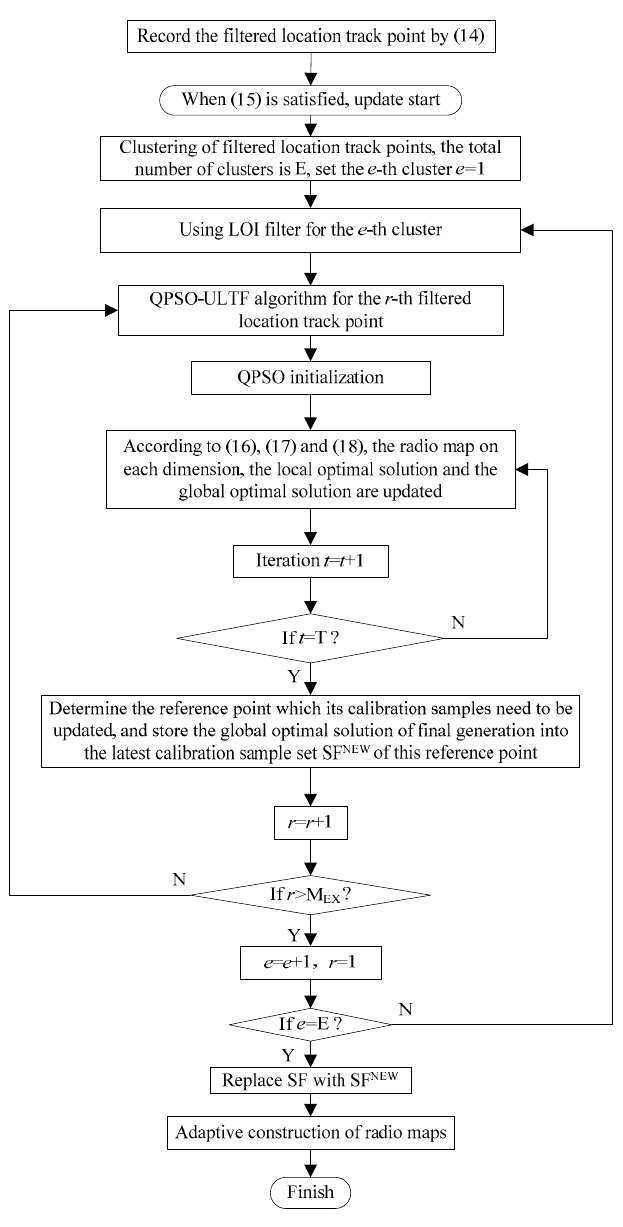
Figure 14. The flowchart of the adaptive update method of the radio fingerprint database based on QPSO–ULTF.